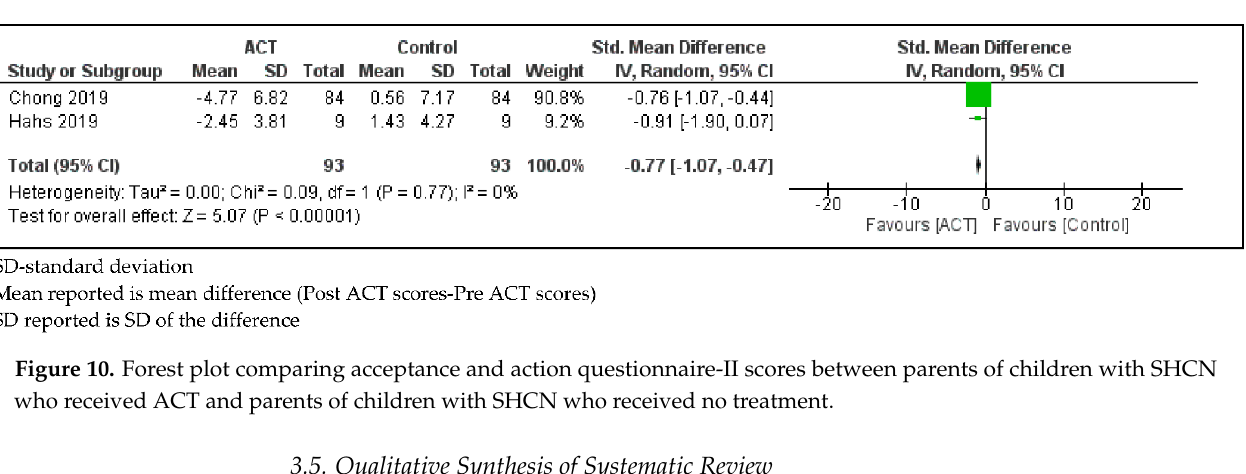
Figure 9. Forest plot comparing Depression, Anxiety and Stress Scale-21 (Anxiety) scores between parents of children with SHCN who received ACT and parents of children with SHCN who received no treatment.